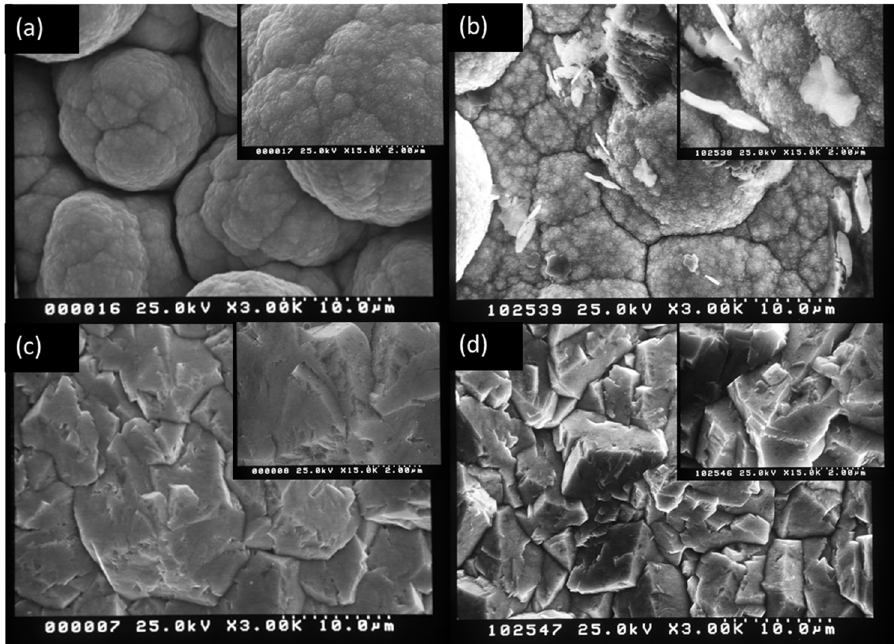
Figure 2. SEM images of ( a ) Ti/α-PbO 2 ; ( b ) Ti/α-PbO 2 used for 5 h; ( c ) Ti/α-PbO 2 /β-PbO 2 ; ( d ) Ti/α- PbO 2 /β-PbO 2 used for 5 h. PbO 2 / β -PbO 2 used for 5